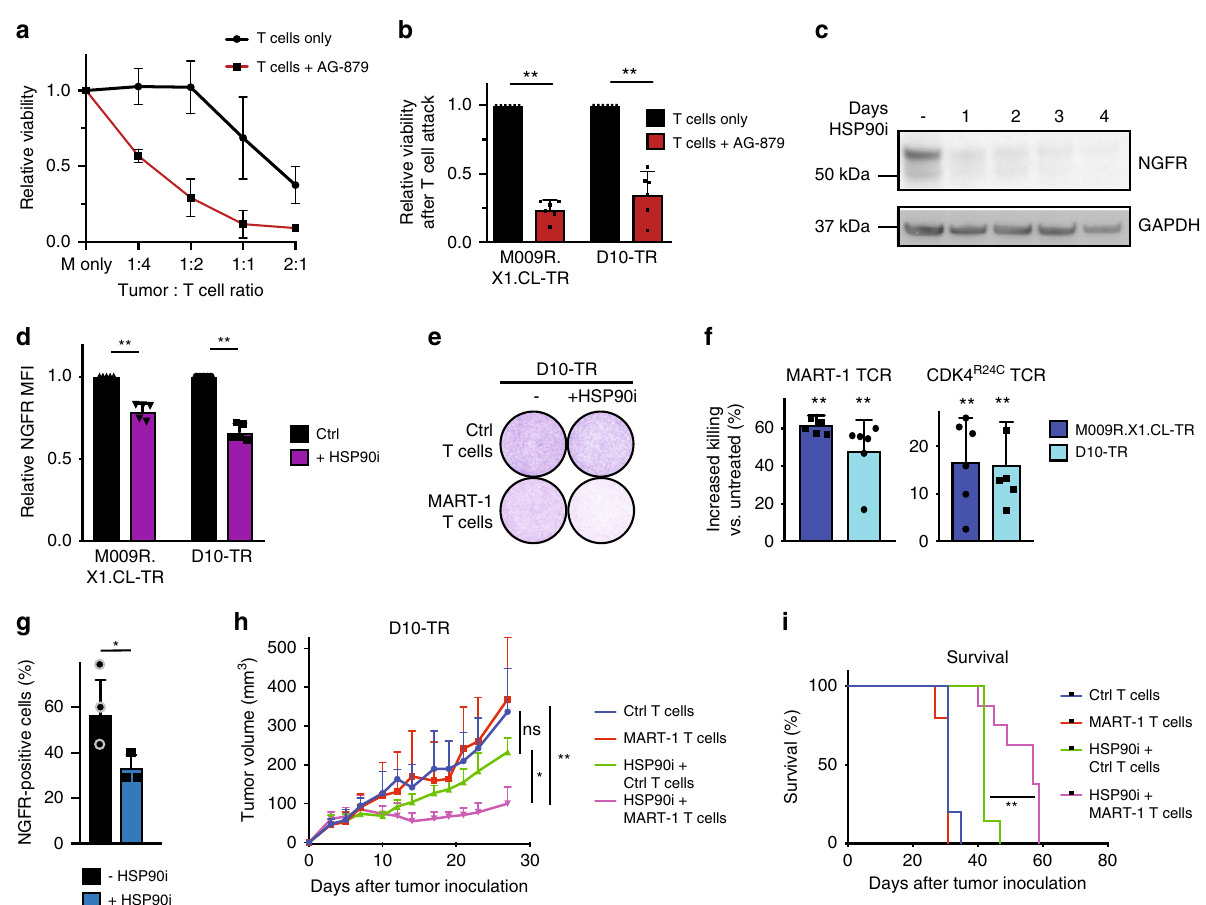
Fig. 7 Pharmacological reversal of NGFR hi state restores T cell sensitivity. a T cell titration in the presence or absence of tyrphostin (AG-879) in M009R.X1.CL-TR cells. b Quanti fi cation of MART-1 T cell cytotoxicity in TR cell lines relative to Ctrl T cells in the presence of absence of AG-879. Error bars represent S.D. of six independent experiments. Statistical analysis by Kruskal – Wallis test; ** p < 0.01. c Western blot analysis on D10-TR cells treated with 250 nM of HSP90 inhibitor ganetespib for the indicated days. GAPDH was used as a loading control (see Source data for other replicate). d Quanti fi cation of NGFR expression by fl ow cytometry after 3 days of ganetespib treatment in vitro. Error bars represent S.D. of fi ve independent experiments. Statistical analysis by Mann – Whitney, ** p < 0.01. e Colony formation assay of D10-TR cells, treated with control (Ctrl) or MART-1 T cells in a 1:1 ratio and/or 250 nM ganetespib for 72 h. Quanti fi cation in f . f Quanti fi cation of cytotoxicity in TR cell lines relative to Ctrl T cells (1:1 ratio tumor cell: T cell) in the presence of absence of ganetespib. Two different sets of TCRs are shown. Error bars represent S.D. of six independent replicates. Statistical analysis by Mann – Whitney test; ** p < 0.01. g Immunohistochemistry scoring of NGFR on D10-TR tumors after vehicle or 100 mg/kg ganetespib treatment in vivo during 6 days for n = 3 mice. Treatment was given on day 1 and day 4. Statistical analysis by unpaired t-test; * p < 0.05. h Tumor growth curve of D10-TR tumor cells after treatment with Ctrl T cells ( n = 5), MART-1 T cells ( n = 5), ganetespib 100 mg/kg + Ctrl T cells ( n = 7), and ganetespib 100 mg/kg + MART-1 T cells ( n = 8). Randomization, T cell injection, and start of ganetespib treatment occurred on day 7. Ganetespib was given twice weekly. Error bars represent S.D. Statistical analysis by Kruskal – Wallis test; ns not signi fi cant, * p < 0.05, ** p < 0.01. i Survival curve belonging